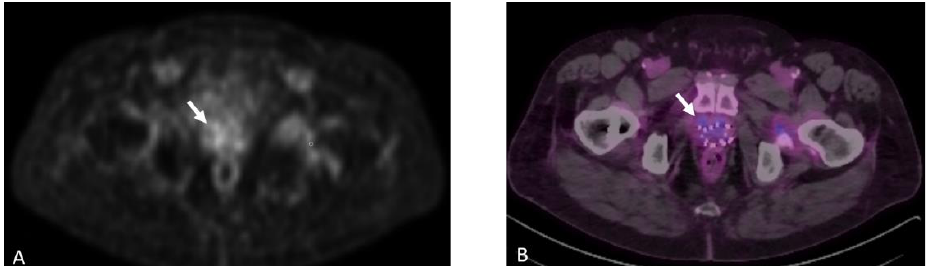
Figure 19. NECT ( A ) shows a round hypoattenuating lesion along the left pelvic sidewall (arrow). Corresponding 18F DCFPyL PET ( B ), fused PET/CT ( C ), and MIP ( D ) images shows that this lesion demonstrates radiotracer uptake. Upon further review, this was found to be excreted radiotracer in the left distal ureter.